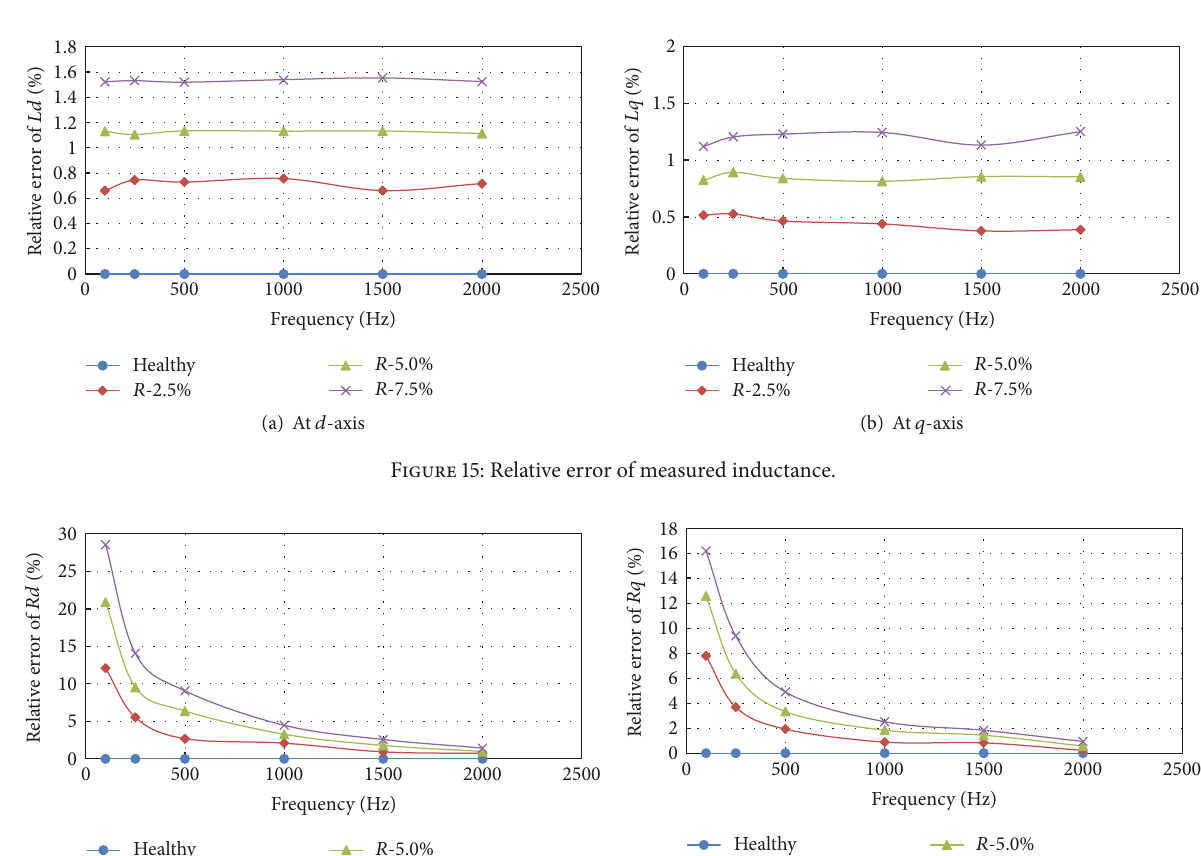
Figure 14: Measured impedance between 𝑢 and 𝑤 terminal at 2000 Hz.